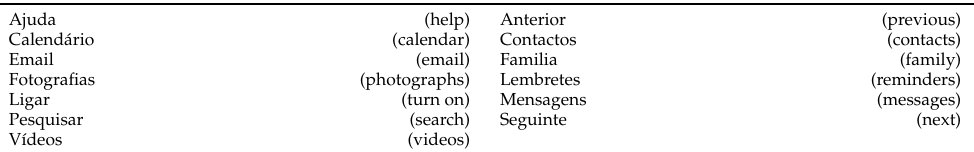
Table 2. Corpus considered for all radar data acquisition sessions, containing a total of thirteen European Portuguese